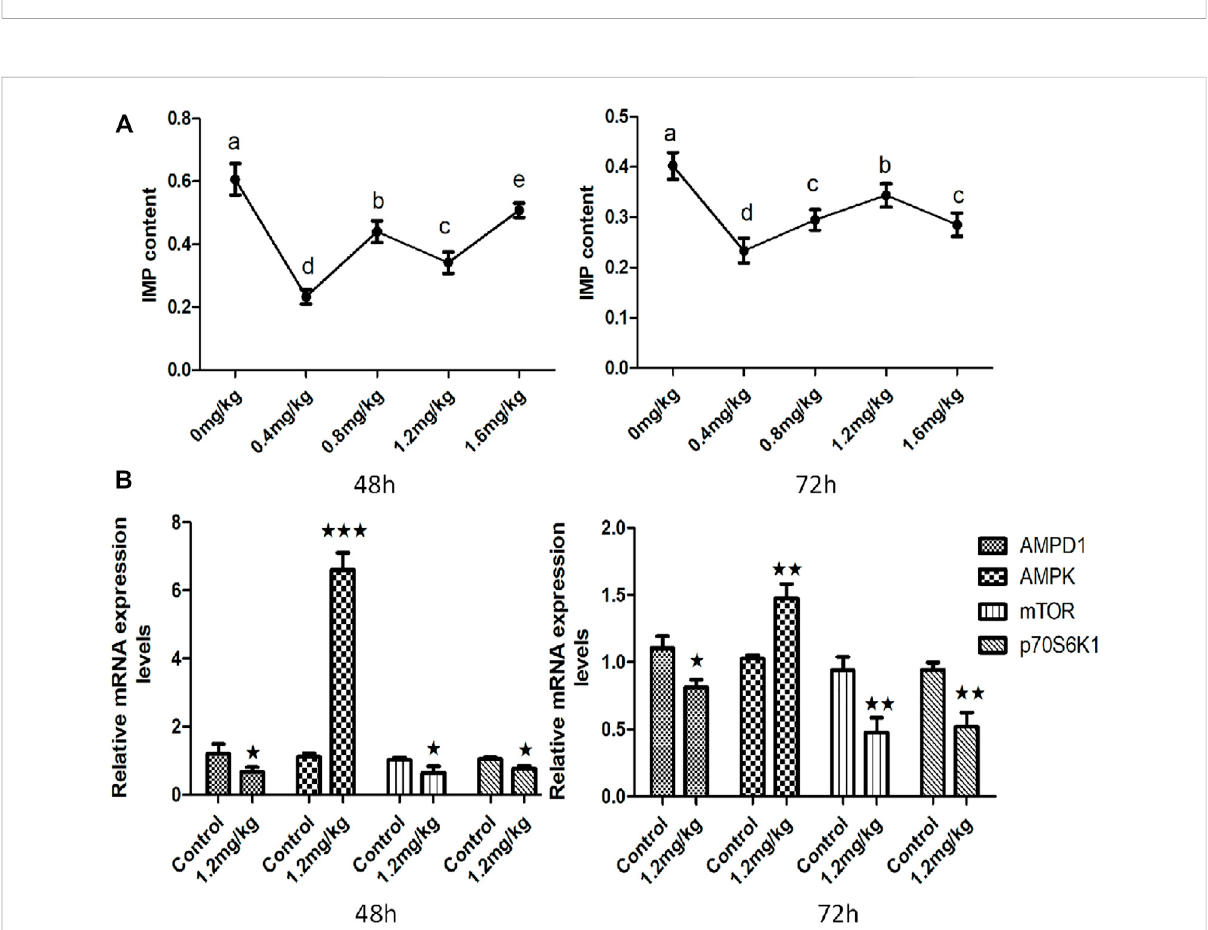
FIGURE 6 EffectsofAMPD1inhibitorinjectiononIMPcontentandtherelativemRNAexpressionofAMPK-mTORsignalingpathwayrelatedgenesfor48 h and72 h invivo . (A) IMPcontent; (B) therelativemRNAexpressionofAMPK-mTORsignalingpathwayrelatedgenes.Errorbarsrepresentthemeans± SD; n = 3. p <